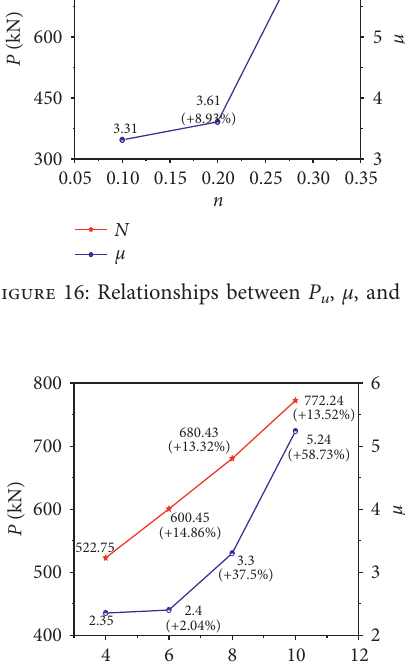
Figure 17: Relationships between P